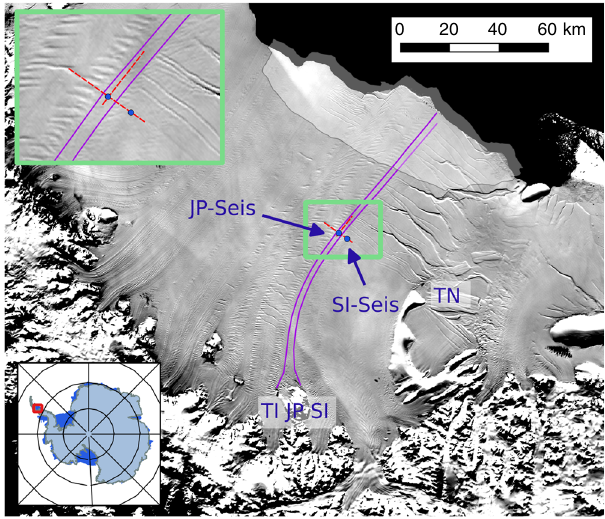
Fig. 2 Larsen C study area in 2008/09. ASTER-GDEM [http://nsidc.org/ data/docs/agdc/nsidc0516-cook/] derived DEM is superimposed on a 2008 MODIS image [https://earthdata.nasa.gov/data/near-real-time- data/rapid-response]. Inset shows location of Larsen C Ice Shelf on the Antarctic Peninsula, with Joerg Peninsula (JP), Trail Inlet (TI), Solberg Inlet (SI) and Table Nunatak (TN) labelled. The magenta lines trace the outlines of the JP suture zone, the fi rst ~50 km of which is its formation area that is laterally compressed (white arrows) as TI- and SI-derived meteoric ice- shelf units converge. The fi lled blue circles mark the locations of our seismic re fl ection pro fi les at JP-Seis and SI-Seis, and the two red dotted arrows show our ground-penetrating radar (GPR) pro fi les across and along fl ow. The solid black arrow indicates the unnamed glacier on the JP that calves glacier-derived blocks into the JP suture zone, and the light grey shaded area indicates the large tabular iceberg (A68) that calved in July 2017 32,33